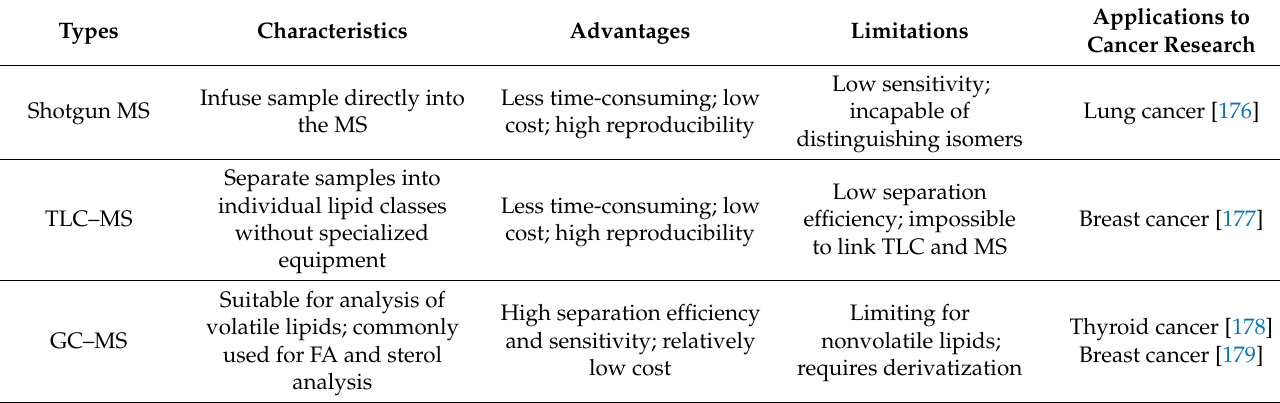
Table 2. Summary of the lipidomics